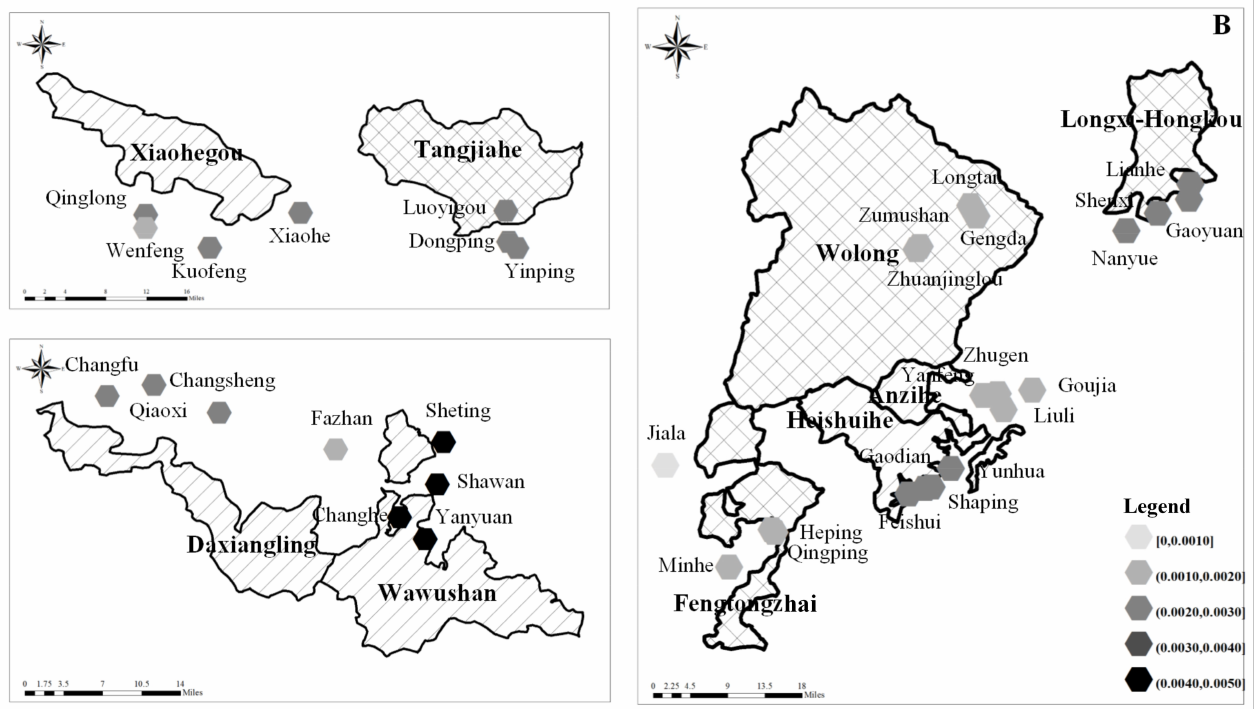
Figure 4. Comprehensive Ecological Niche on the level of giant panda habitat under the different age dominated natural resource utilization. Notes: ( A ) Comprehensive Ecological Niche of OAG. ( B ) Comprehensive Ecological Niche of YAG. Map Content Approval Number: CS (2019) 282.